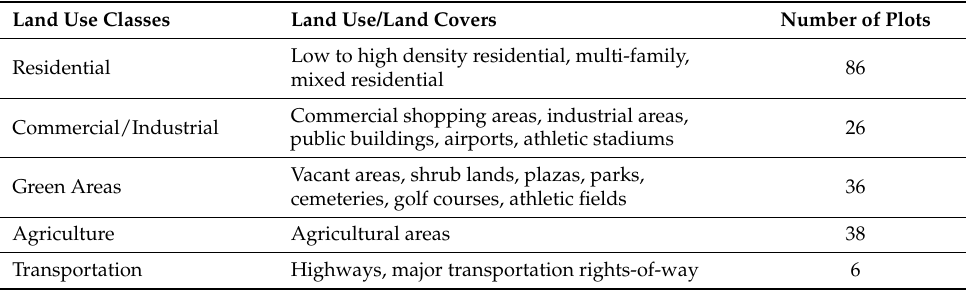
Figure 1. Plot locations within the Santiago de Chile study area in 2002 ( left ) and 2014 ( right ). Plots located on high, medium, and low socioeconomic strata are represented in red, gray, and blue circles, respectively. Vegetated land covers are green in color, bare soil areas are in pink, while orange and brown depict sparsely vegetated areas. High to low urban density areas are dark to light magenta, respectively, and dark magenta, linear features are major transportation rights of way. Linear light magenta areas in the southeast and far east in the Andean foothills are a river flood plain and barren rock, respectively. Note: images are from Landsat-7 RGB 742 taken on February 2002 and January 2014. Table 1. 2002 land use/cover classes analyzed in Santiago, Chile.